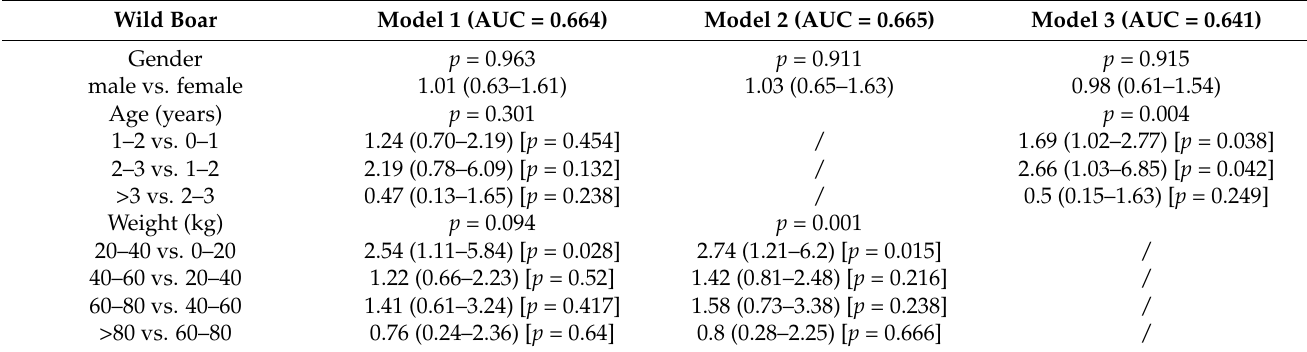
Table 2. Risk factors for the prevalence of T. gondii in wild boar. The results are OR (95% confidence intervals) and p -values.